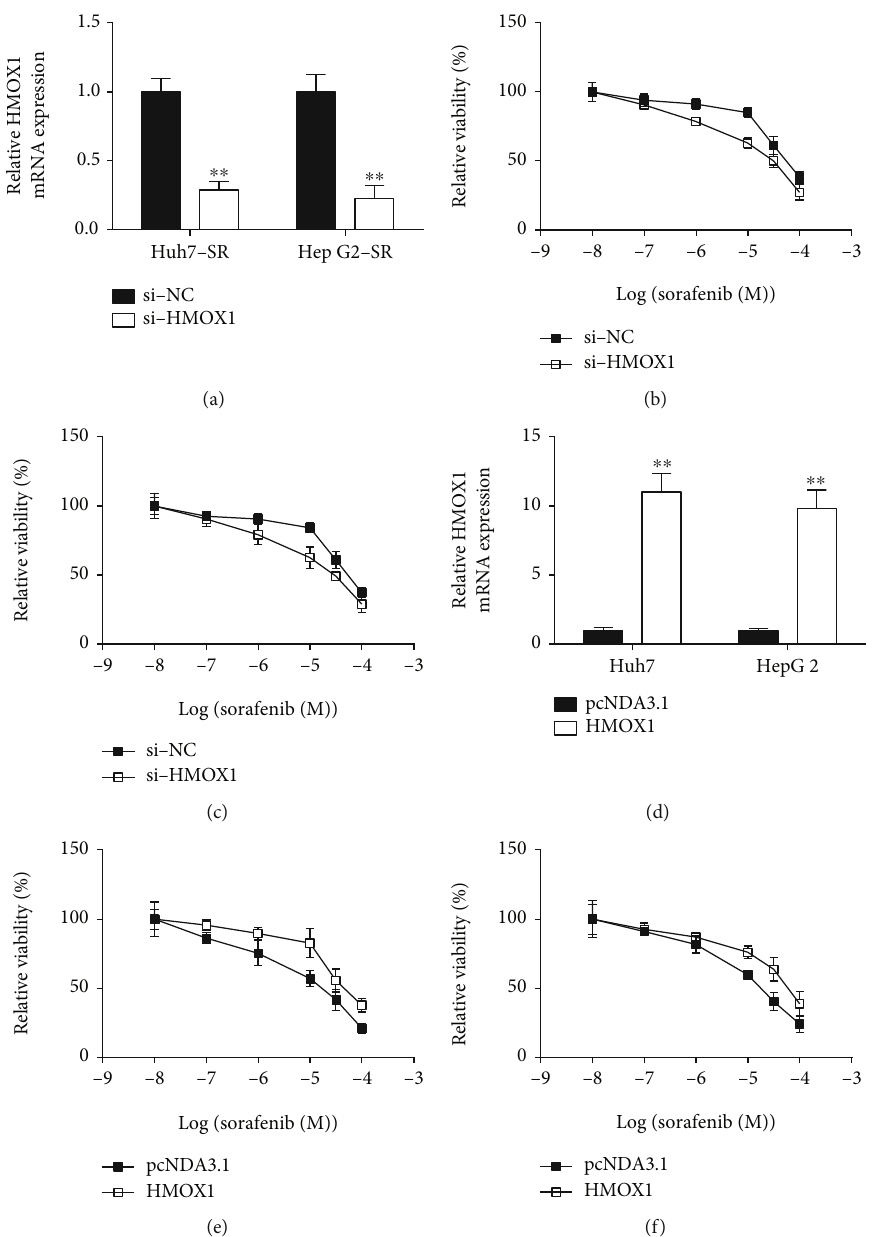
Figure 6: E ff ects of HMOX1 on the sensitivity of HCC cells to sorafenib. (a) The relative mRNA expression of HMOX1 in Huh7-SR and HepG2-SR cells after scrambled siRNA (si-NC) or HMOX1 siRNA (si-HMOX1) transfection. (b) The relative viability of scrambled siRNA (si-NC) or HMOX1 siRNA- (si-HMOX1-) transfected Huh7-SR cells after being treated by sorafenib was determined by MTT assay. (c) The relative viability of scrambled siRNA (si-NC) or HMOX1 siRNA- (si-HMOX1-) transfected HepG2-SR cells after being treated by sorafenib was determined by MTT assay. (d) The relative mRNA expression of HMOX1 in Huh7-SR and HepG2-SR cells after pcDNA3.1 or pcDNA3.1-HMOX1 transfection was determined by qRT-PCR. (e) The relative viability of pcDNA3.1 or pcDNA3.1-HMOX1 transfection-transfected Huh7-SR cells after being treated by sorafenib was determined by MTT assay. (f) The relative viability of scrambled pcDNA3.1 or pcDNA3.1-HMOX1 transfection-transfected HepG2-SR cells treated by sorafenib was measured by MTT assay. N = 3 . ∗∗ P < 0 : 01